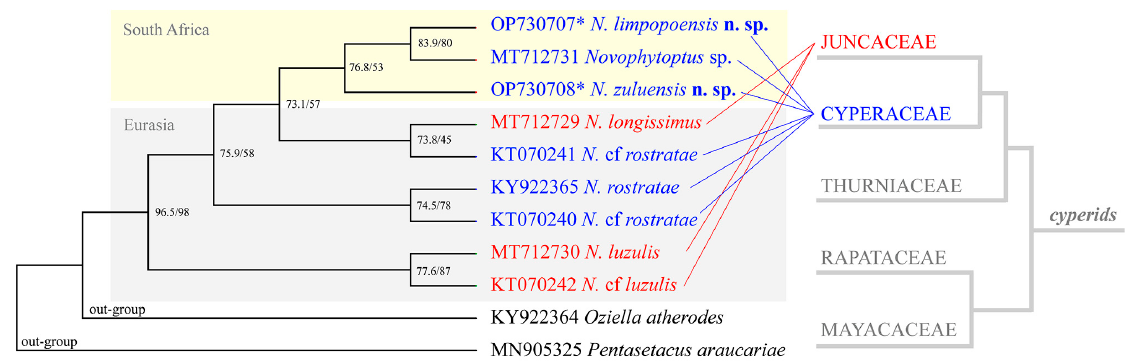
Figure 9. Maximum likelihood tree based on a 388-amino-acid alignment of the translated Cox1 gene showing phylogeny of Novophytoptus . Nodes are labeled by values of SH-aLRT single branch test/UF bootstrap support (UFBS). Mite species associated with Cyperaceae and Juncaceae are colored blue and red, respectively. Two geographical groups of Novophytoptus species recorded from Africa and Eurasia are highlighted yellow and gray. Phylogeny of cyperids (simplified from [19]) is shown on the right. New sequences of Novophytoptus obtained in this study are indicated by asterisks.